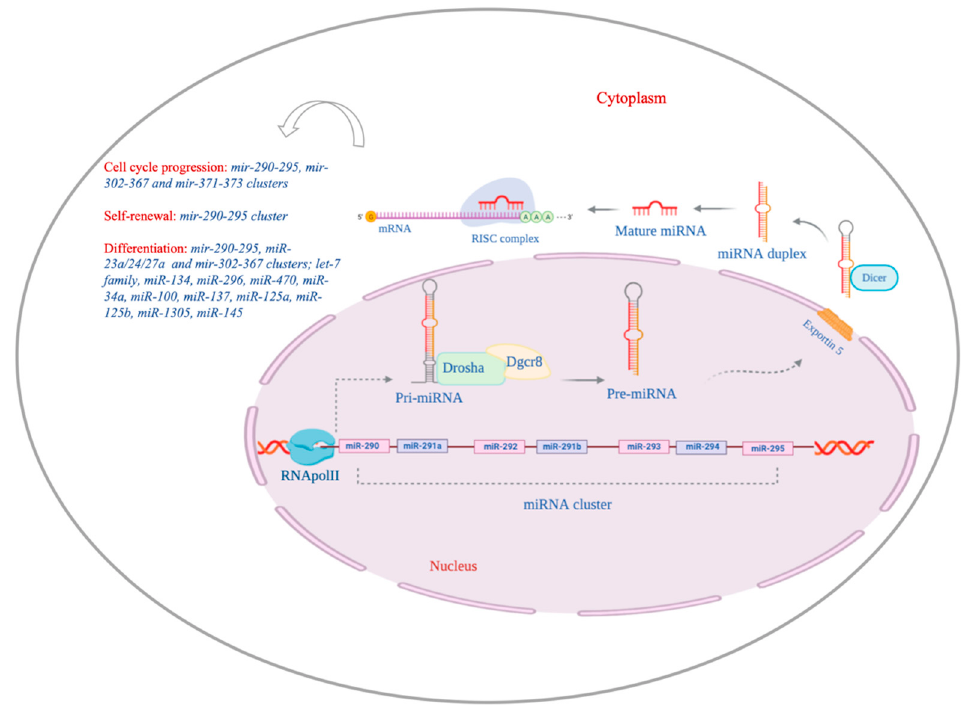
Figure 1. MicroRNA pathway in ESCs (embryonic stem cells). MiRNA genes can be organised in clusters as that of mir-290 . Their biosynthesis starts in the nucleus when the RNA POL II generates a long primary transcript, with hairpin stem-loop structure, named pri-miRNA. The stem-loop cropping mediated by DROSHA / DGCR8 complex converts the pri-miRNA into a pre-miRNA, that reaches the cytoplasm through the EXPORTIN 5-mediated transport. Here, a processing of the pre-miRNA terminal loop by the endonuclease DICER generates a small miRNA duplex as intermediate. The mature miRNA strand is guided by RISC to bind the mRNA target, promoting its degradation / destabilization. MiRNAs orchestrate important functions as cell cycle regulation, self-renewal and di ff erentiation of ESCs.